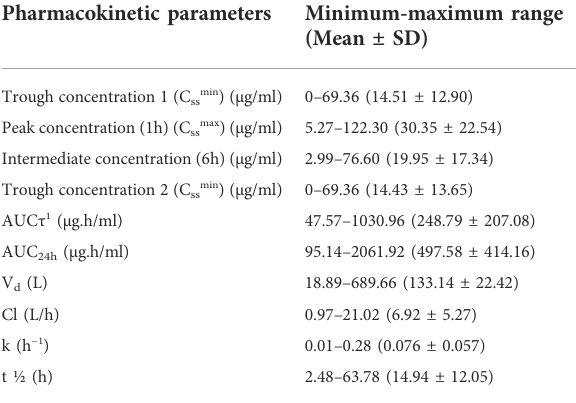
TABLE 4 The correlation between baseline serum creatinine and baseline GFR and pharmacokinetic parameters.